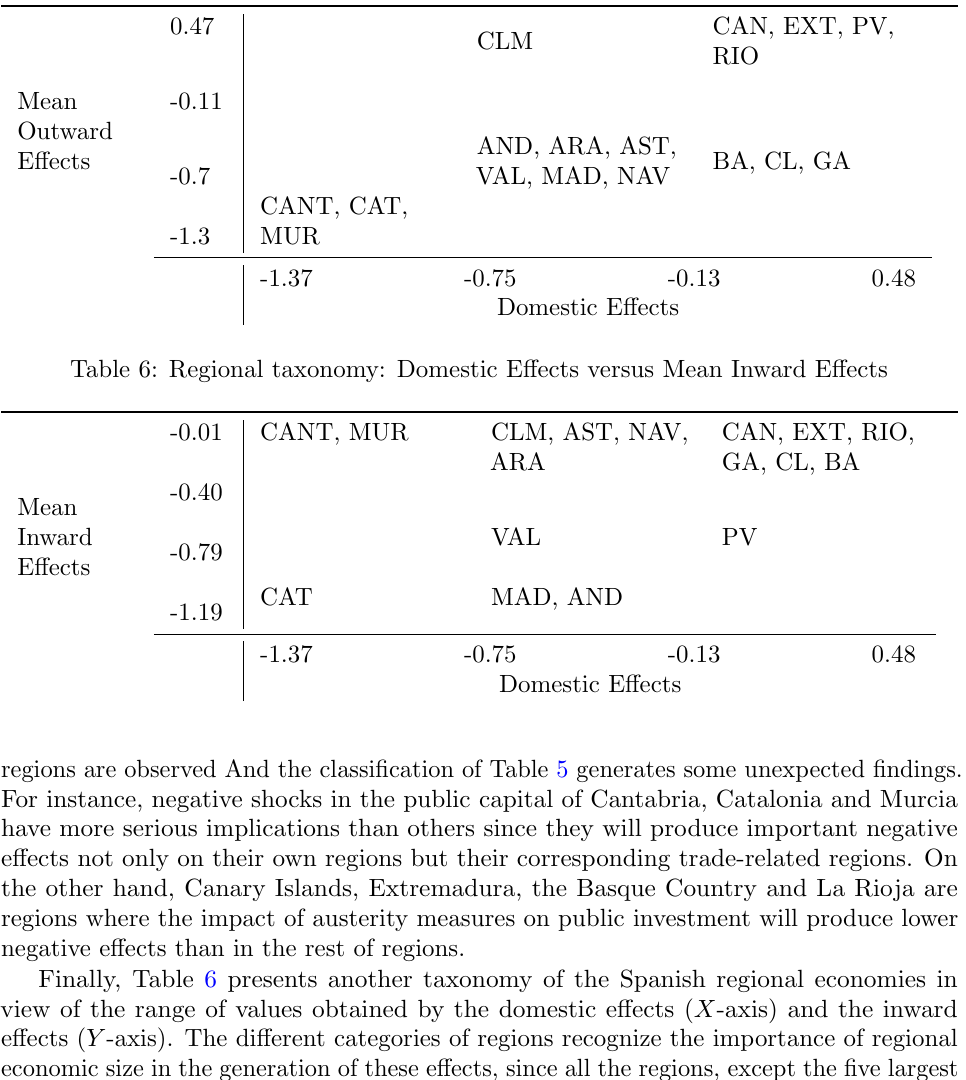
Table 5: Regional taxonomy: Domestic Effects versus Mean Outward Effects